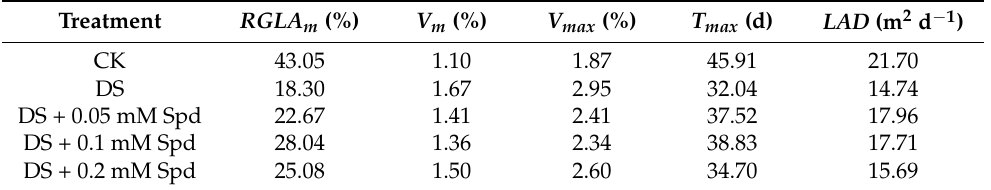
Table 6. Effect of exogenous spermidine on leaf senescence characteristics of maize leaves under drought stress.